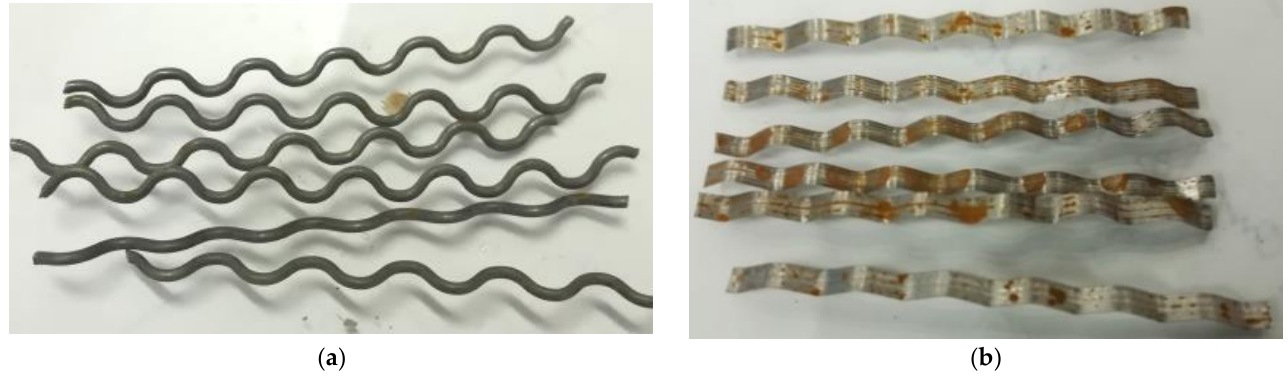
Figure 10. Fibers after one month of pH test. ( a ) RW50, and ( b ) RW50+. During the tensile strength testing, some difficulties were found in the shortest fibers since the jaws could not hold the fibers properly. While PP-ST42 and PP-CN54 fibers were tested, PP-ST30, NS12, NS18, all glass fibers (HD3, HD6, HD12, HP) and tire rubber fibers